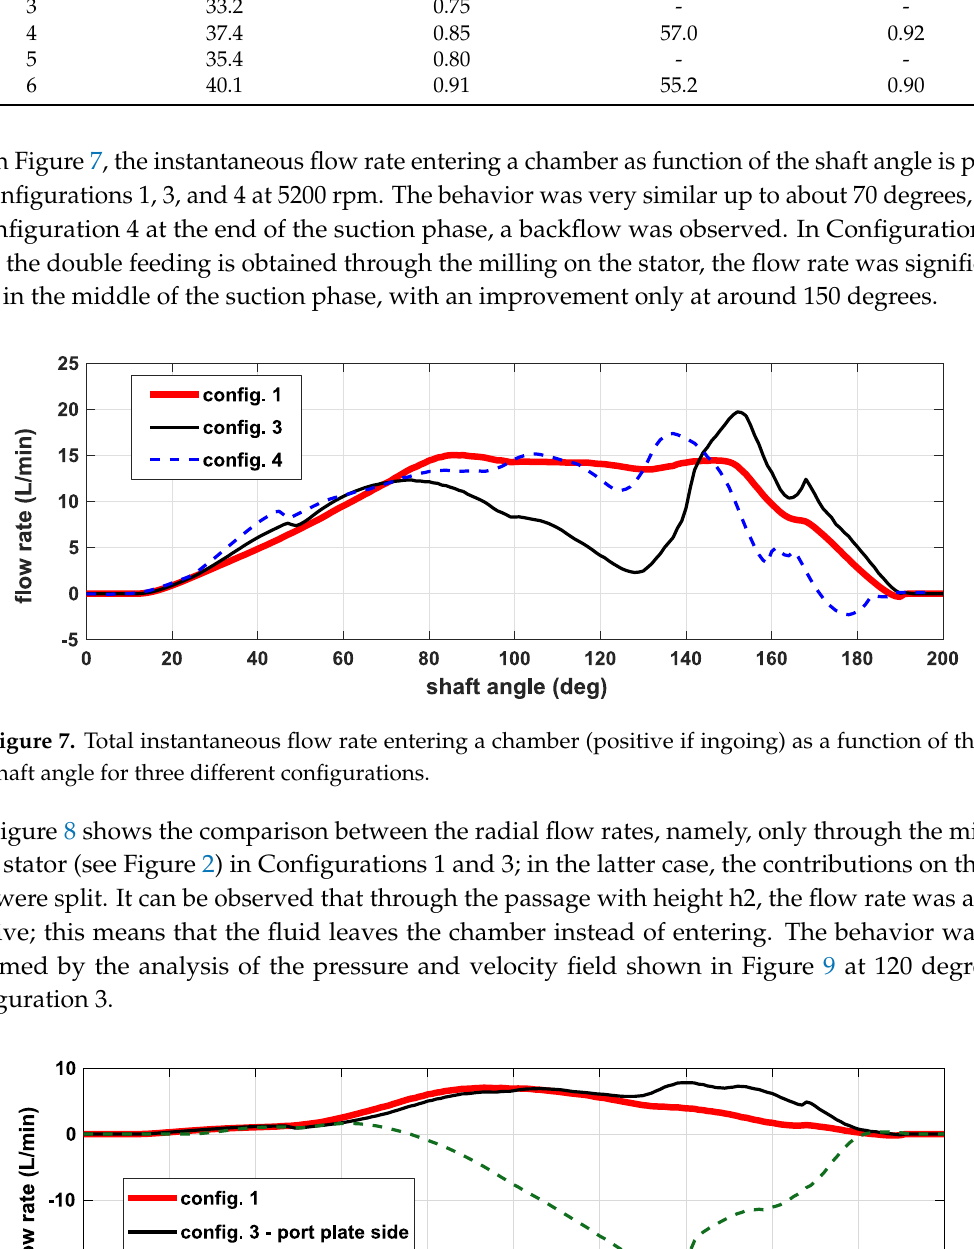
Table 2. Simulated flow rate and volumetric efficiency at 5200—partial displacement (55%) and at 4400 rpm—full displacement (100%).